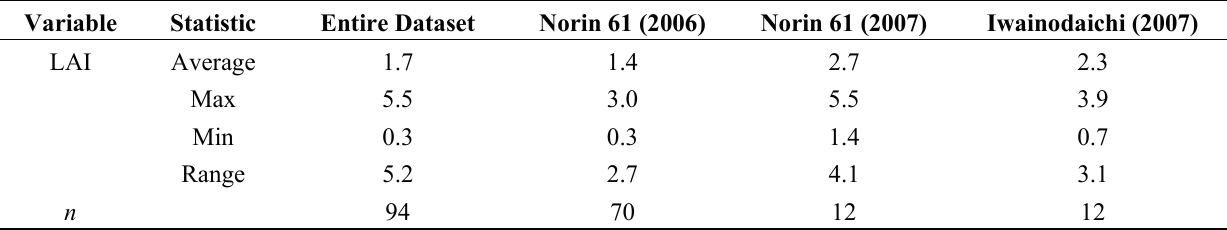
Table 4. Summary statistics of the field LAI